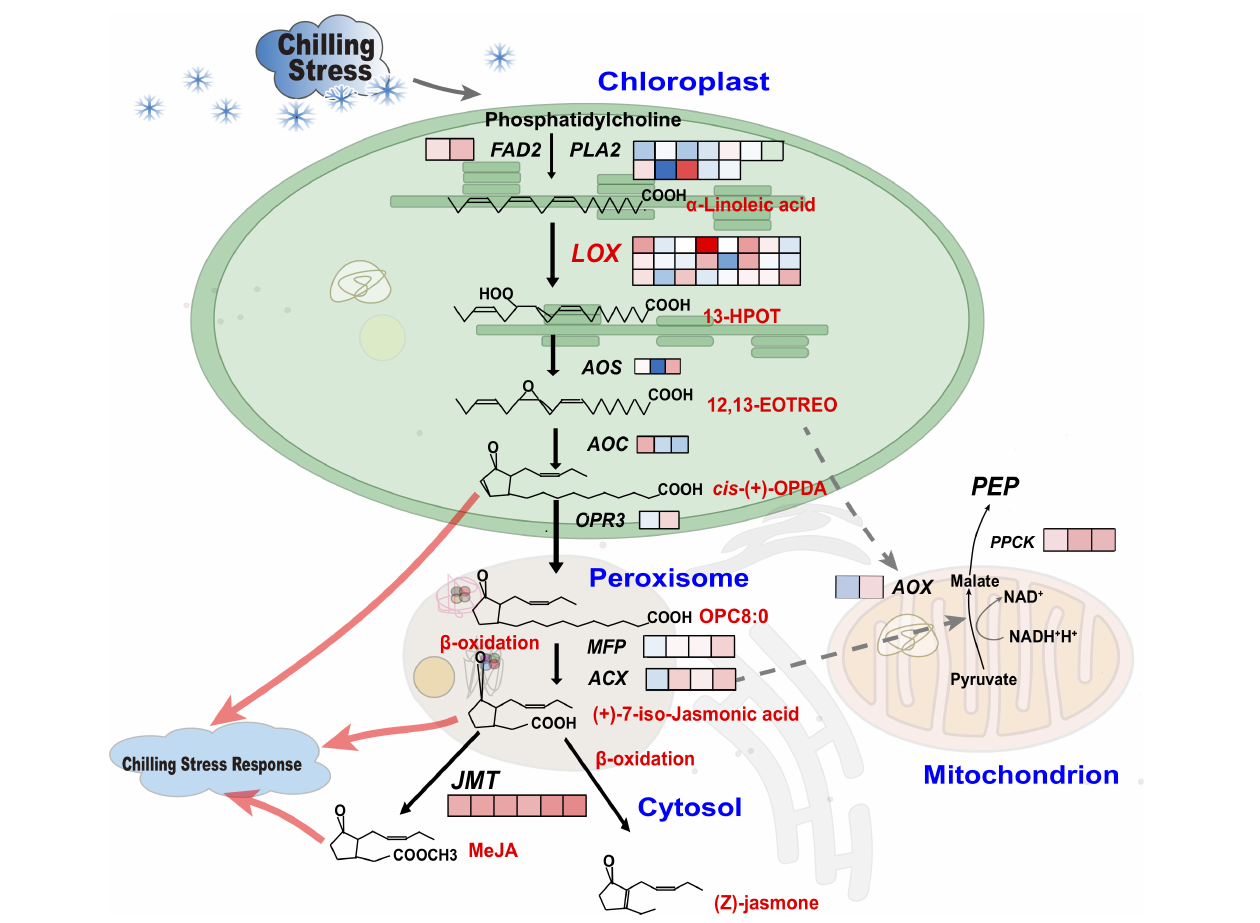
FIGURE 7 | Unsaturated fatty acid, β -oxidation and energy metabolism pathways in leaves and roots of pumpkin rootstocks. Fatty acid desaturase and phospholipase genes regulate the production of α -linolenic acid in chloroplasts. Components of linolenic acid metabolism and subsequently unsaturated fatty acid metabolites of the α -linoleic acid metabolism pathway are metabolized by LOX/AOS/AOC/OPR3 . The processes of OPC8:0 formation from fatty acid hydroperoxide, β -oxidation and MeJA biosynthesis occur in the peroxisome and are regulated by MFP/ACX . The ACXs are involved in the conversion of pyruvate to malate, which is associated with NAD energy production in mitochondria. In addition, AOXs mediate signal transduction between mitochondria and chloroplasts. Boxes indicate the log 2 (fold change of FPKM) changes in gene expression levels. The different boxes indicate the corresponding homologous DEGs in pumpkin transcriptomic analysis between normal and chilling conditions.